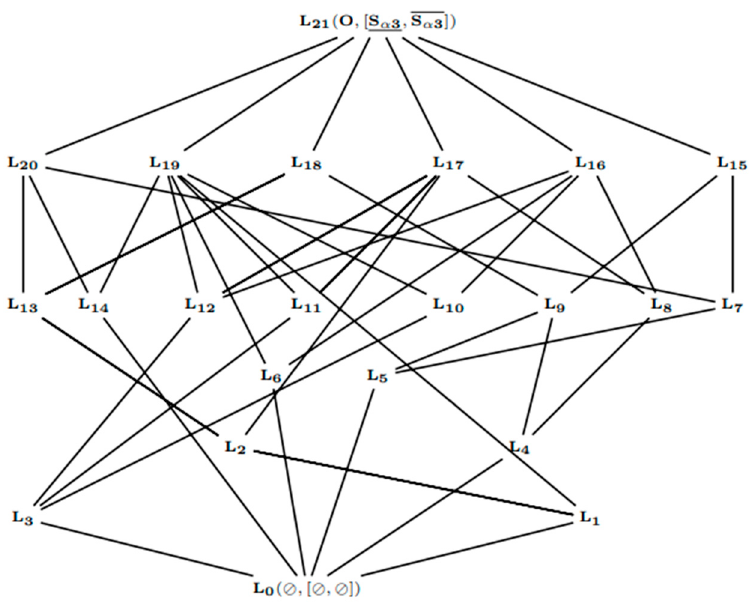
Figure 9. From Table 𝑆 (cid:3080)